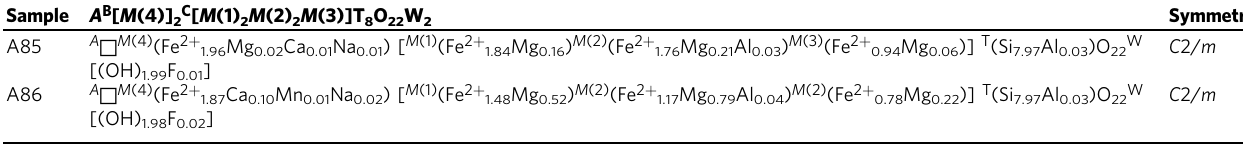
Table 1 Crystal-chemical formulae, obtained by combining electron – microprobe, XRD, and Mössbauer analyses, and space-group symmetry at room temperature for the studied samples; elements with <0.005 atoms per formula unit (apfu) were